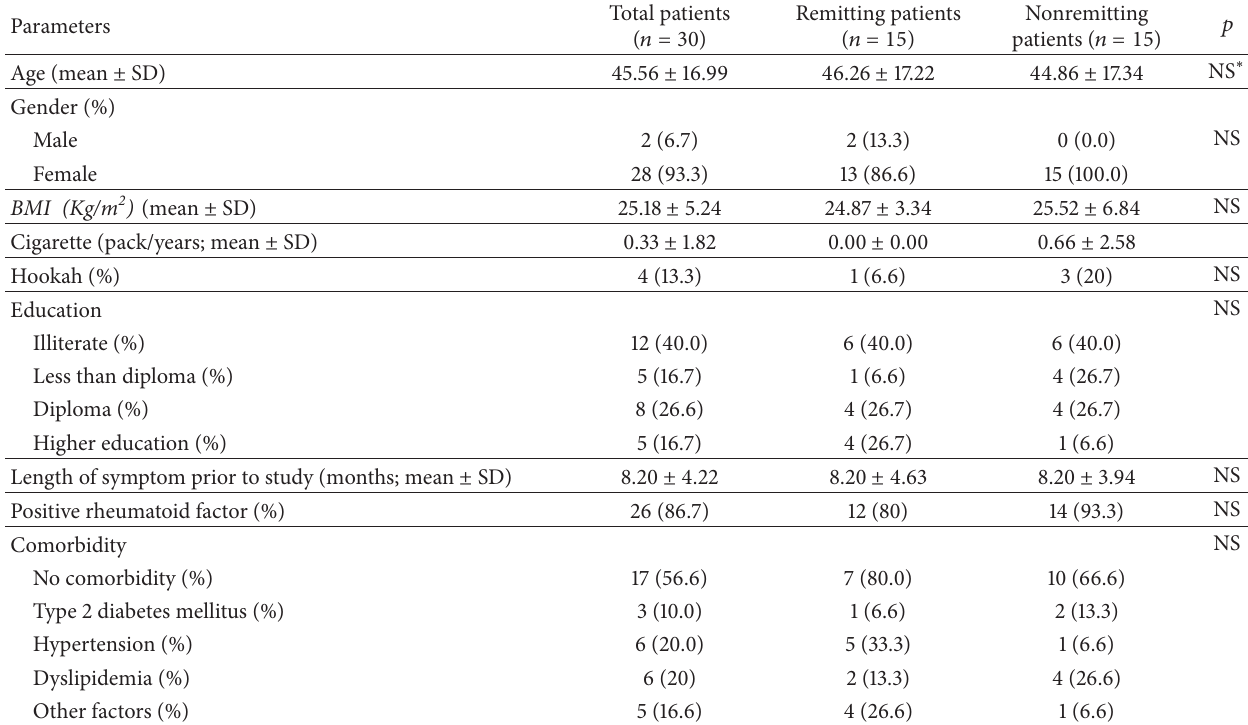
Table 4: Baseline demographic and clinical characteristics of total follow-up cohort and the remitting and nonremitting subgroups. Parameters